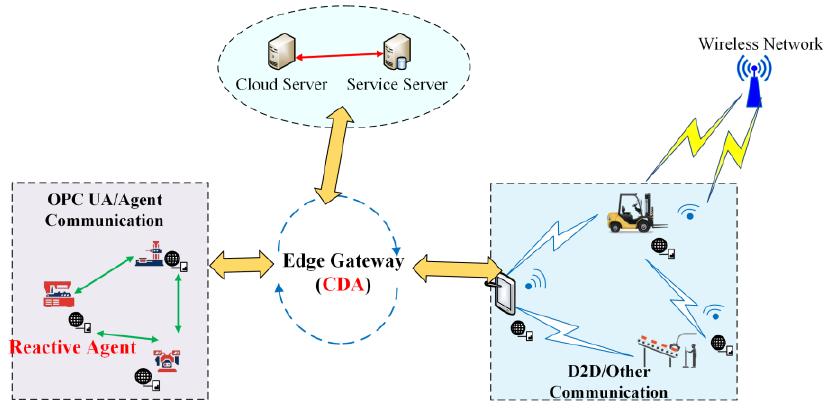
Figure 6. Schematic description of the network communication channel.